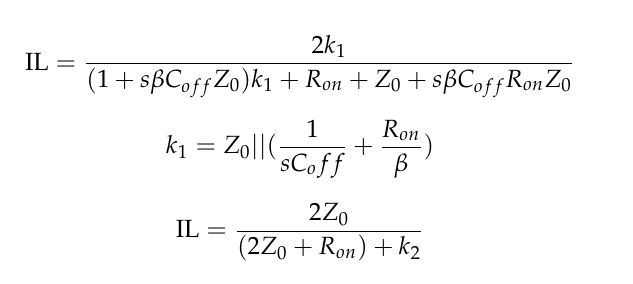
Figure 11. The equivalent-circuit of RF